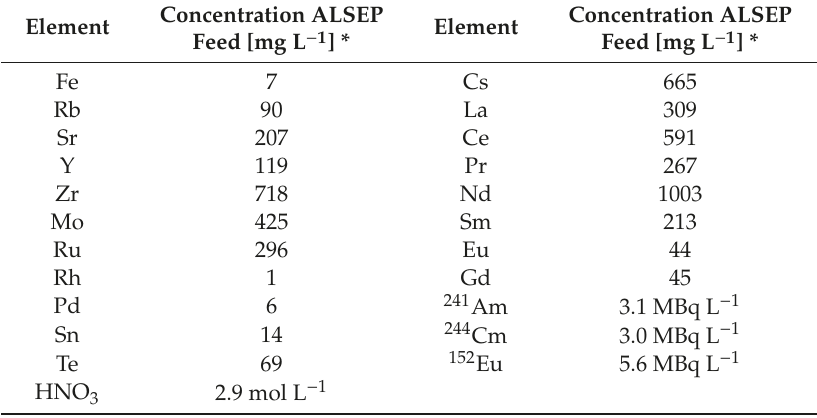
Table 1. Composition of the synthetic Actinide Lanthanide Separation Process (ALSEP) feed